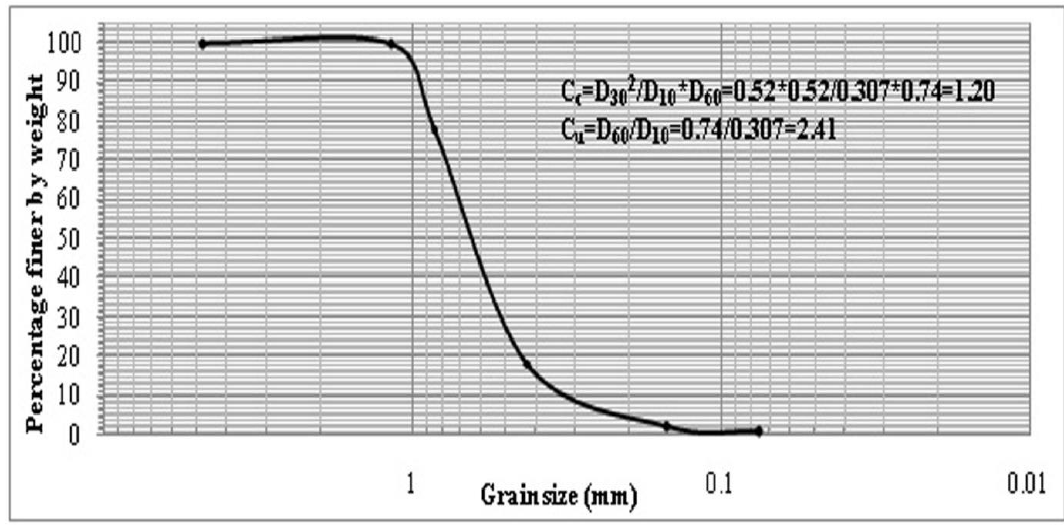
Fig. 3. Grain size distribution curve for